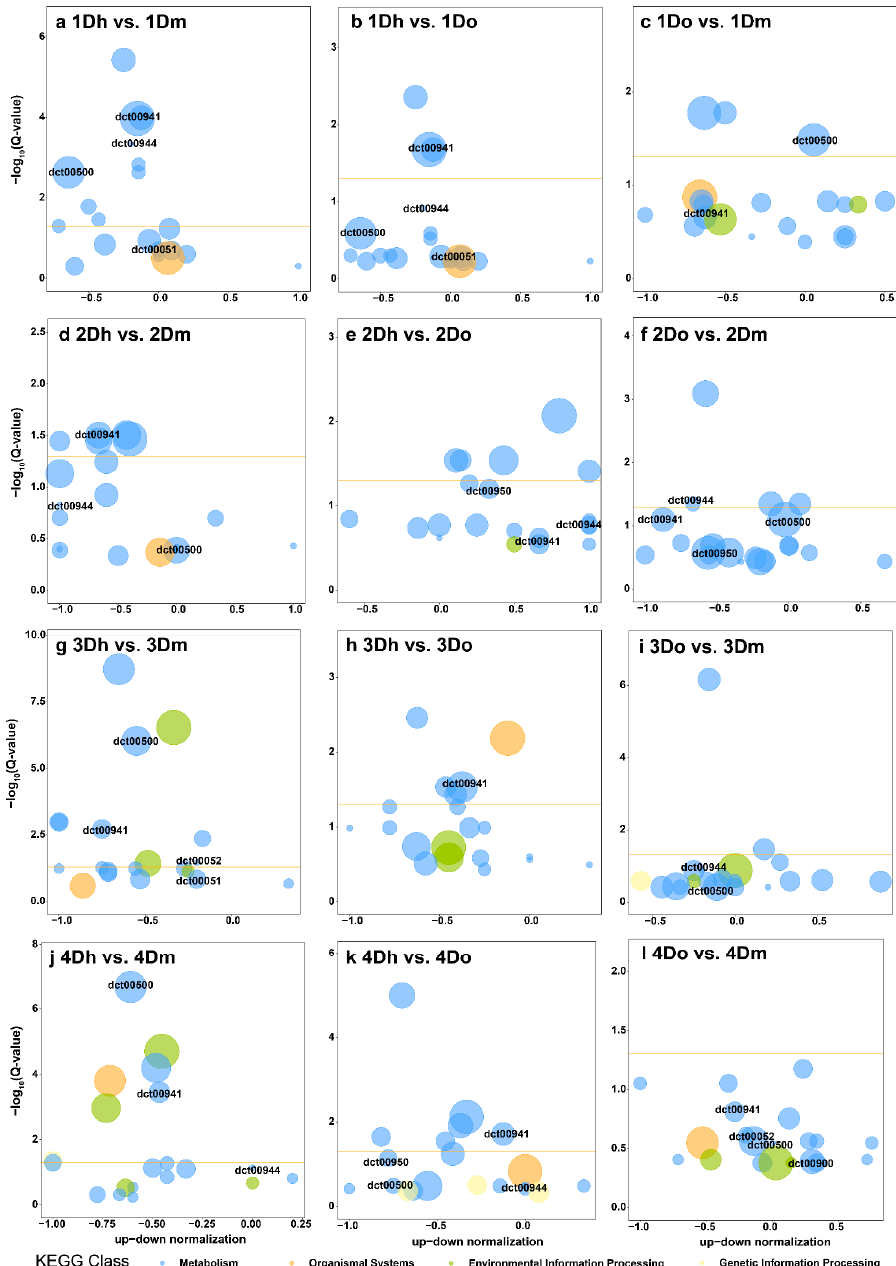
Figure 5. KEGG enrichment bubble diagram of DEGs. X-axis represents Z-score. Y-axis represents- log 10 ( p -value). Bubble size represents the number of DEGs, and bubble color represents KEGG classification. The orange threshold line indicates p = 0.05.